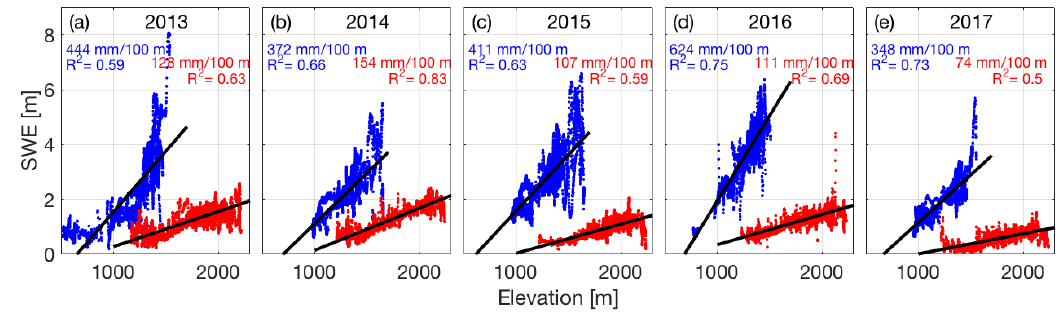
Figure 4. SWE from GPR surveys as a function of elevation, along with least squares regression slope and coefficient of determination for each year of the study period. Wolverine is plotted in blue, Gulkana in red.